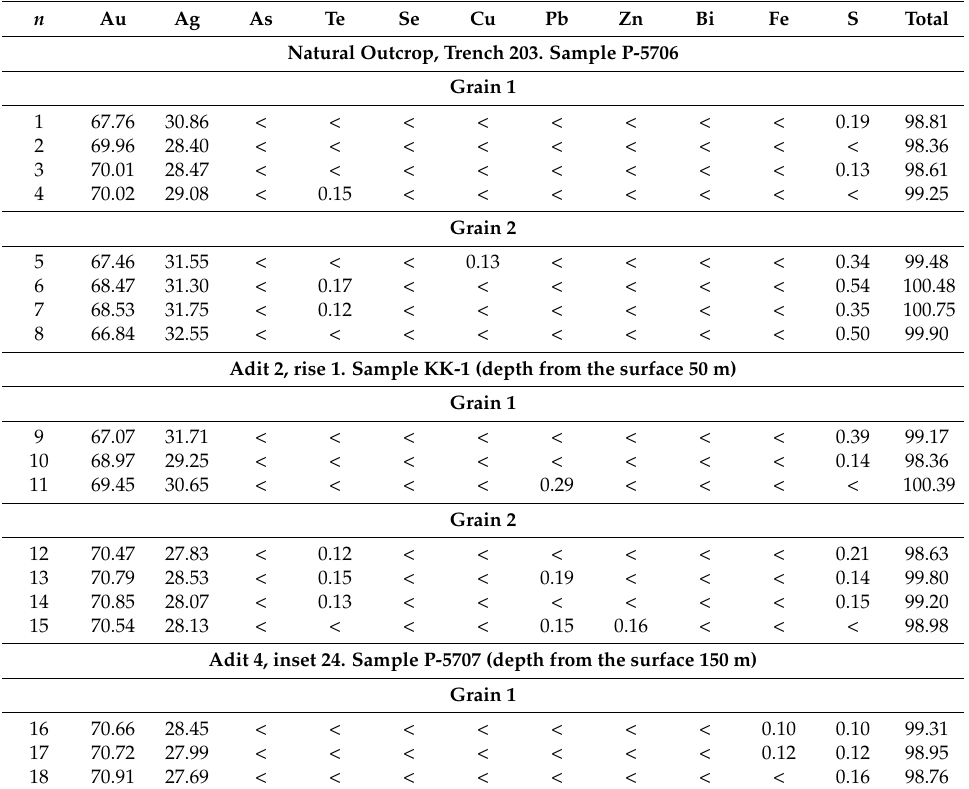
Table 4. Representative EPMA analyses of native gold from the Kvartsevaya Sopka deposit (wt %).